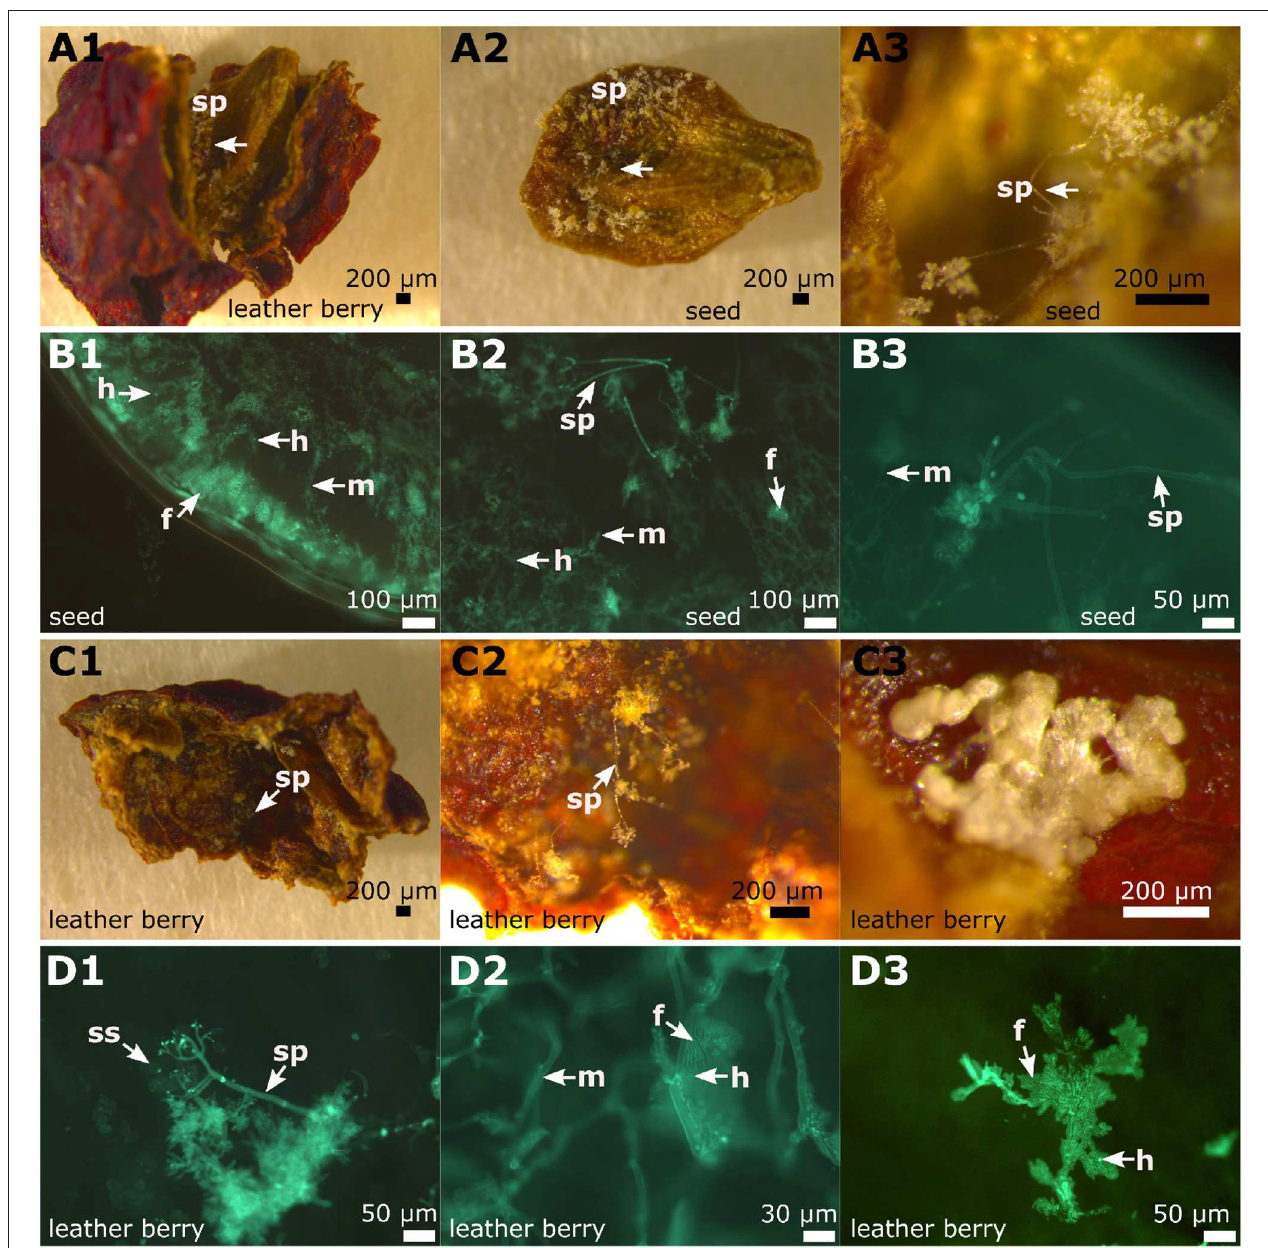
FIGURE 9 | Microscopy of infected berries and seeds. The inspection of the late infected berries (example from “Pinot blanc”). (A1–A3) Binoscopic image (A1) of an infected berry and its seeds with typical signs of late P. viticola infection. Inside the berry, a seed is completely covered with sporangiophores. These grow mainly at the concave side of the seed. (B1–B3) Microscopy of transversal section of a seed with its surface covered with sporangiophores. The seed is completely infiltrated by hyphae, that produce haustoria and fan-shaped hyphae. The surface shows typical sporangiophores and hyphae inside. (C1–C3) A frequently appearing picture: The inner skins (85% of investigated infected berry skins) of the berries are covered with sporangiophores and at irregular intervals “cushion-like” hyphae appear. (D1–D3) According to microscopic evaluation the “cushion-like” hyphae correspond to fan-shaped hyphae. m, mycelium; f, fan-shaped hyphae; sp, sporangiophores; h, haustoria; ss,